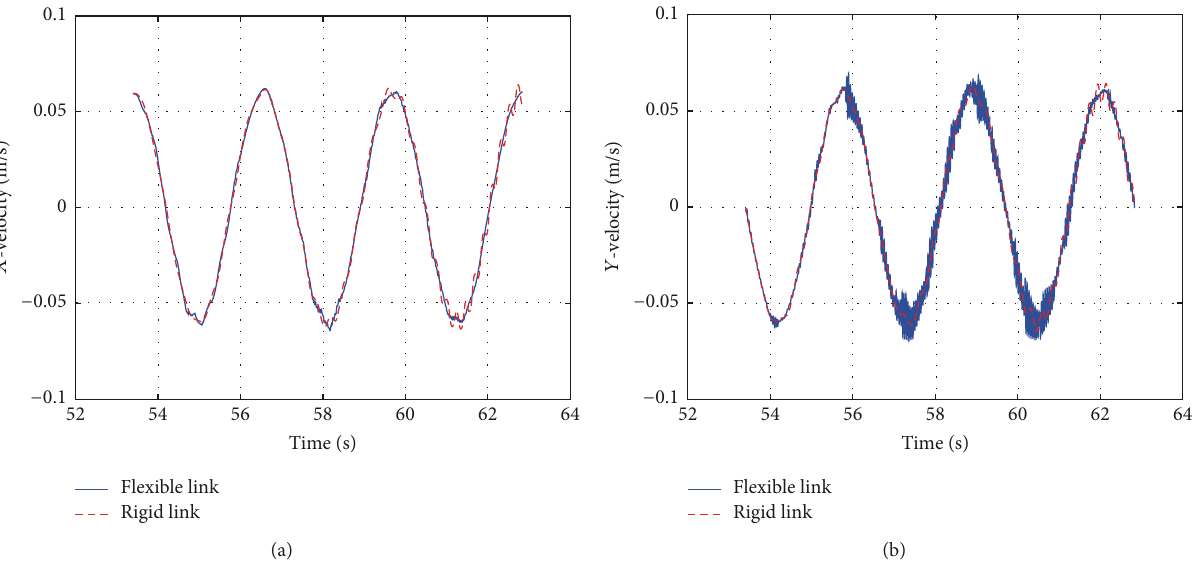
Figure 9: Velocity diagram of the moving platform: (a) velocity in 𝑋 direction; (b) velocity in 𝑌